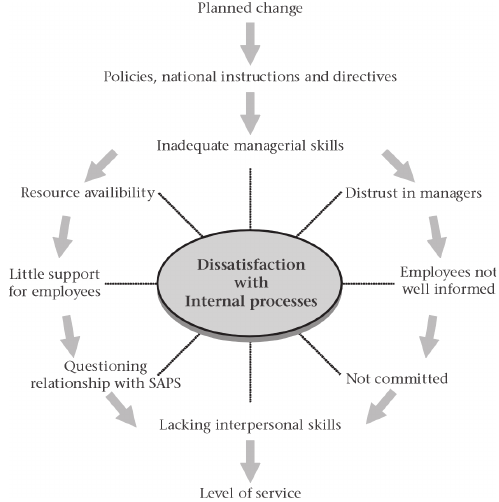
Figure 1: Current application of policies and